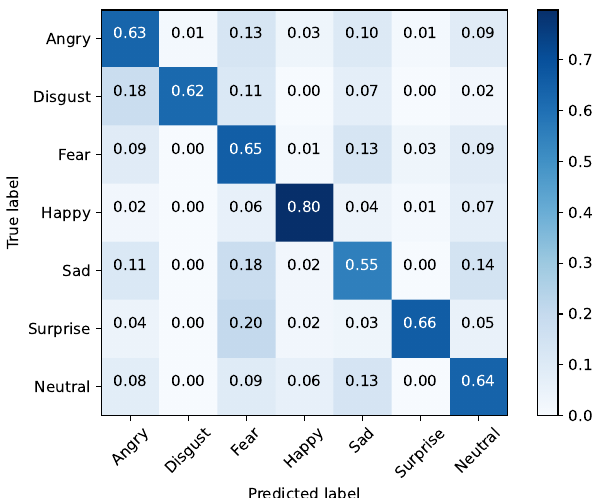
Figure 2. Xception—training set